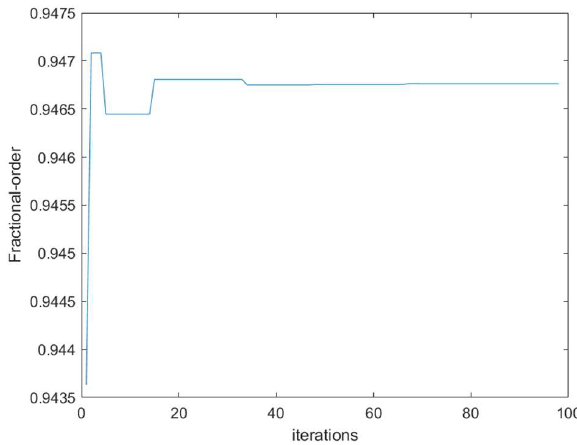
Figure 4. Fractional-order convergence process of model 3.